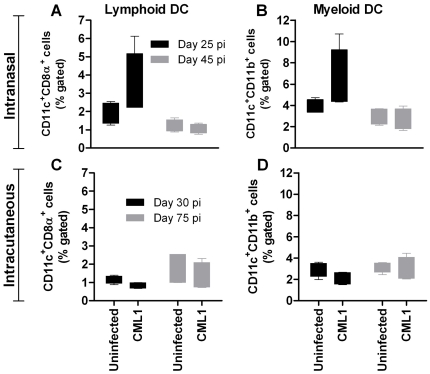
DLN responses to CML1 in nu/nu mice following i.n. or i.c. infection.Mice received PBS (uninfected) or 2.0×106 PFU of CML1. At 25 and 45 dpi for the i.n. model (A–B) or at 30 and 75 dpi for the i.c. model (C–D), DLNs (pool of inguinal, axillary, mesenteric and lumbar lymph nodes) were collected and the CD11c+CD8α+ lymphoid and CD11c+CD11b+ myeloid DCs were identified. The magnitude of DC responses is depicted as percent gated cells plotted on box- and whiskers-graphs. Bars represent Min to Max whiskers (n = 4 individual mice for each group). Results were submitted to unpaired t test but the differences between the groups were not significant.